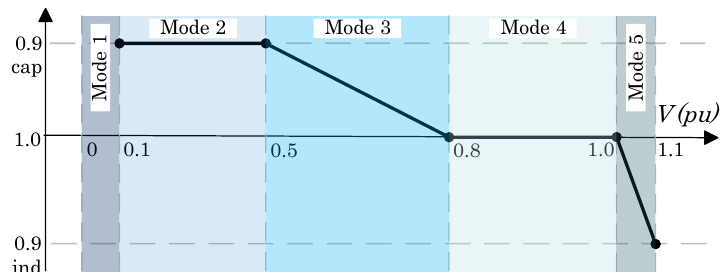
Figure 3. IBDG V × pf curve under normal and abnormal voltage